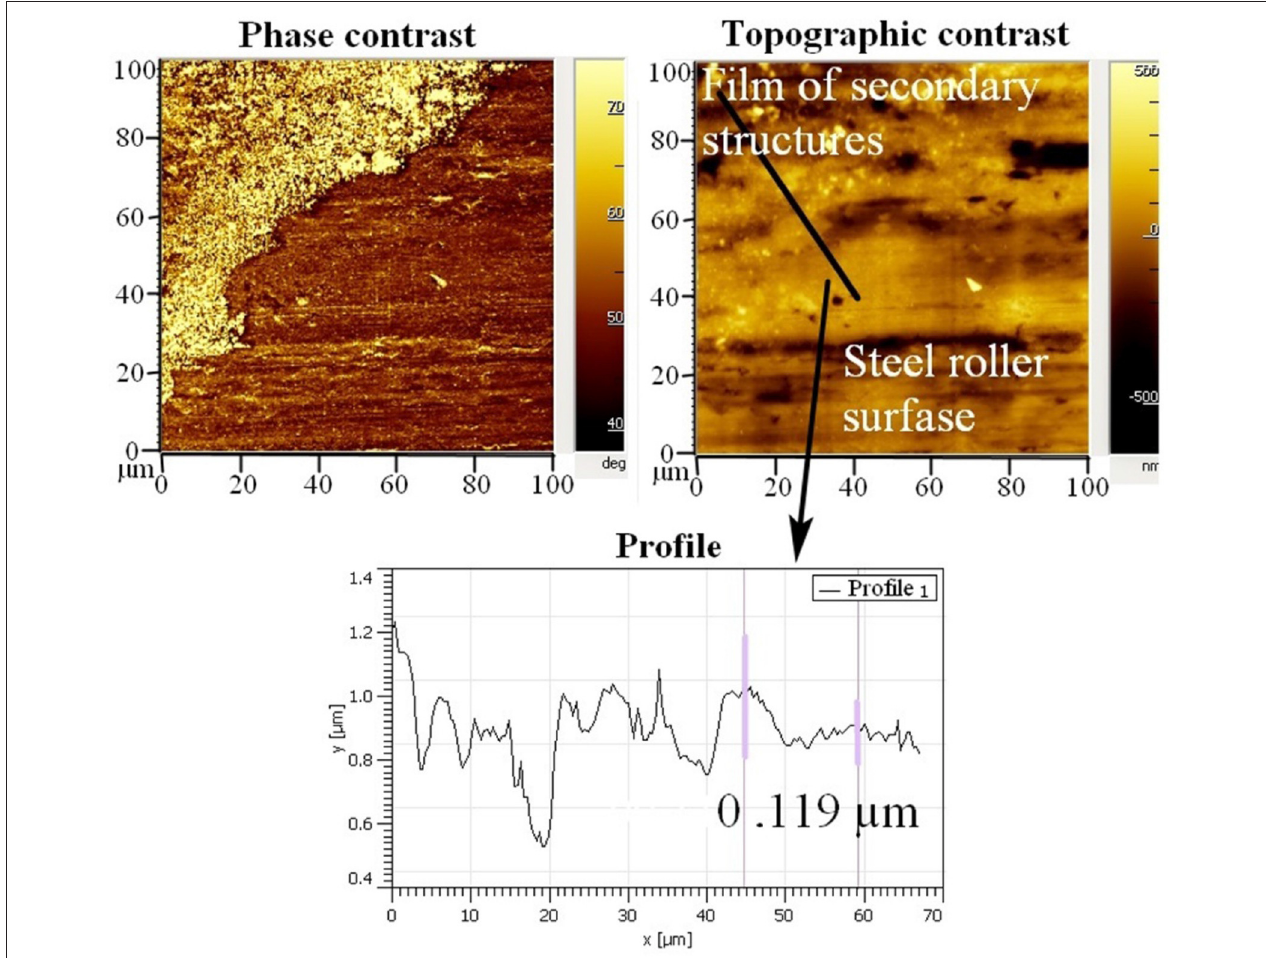
FIGURE 6 | SPM image of the roller surface after testing in lubrication; profile of the section